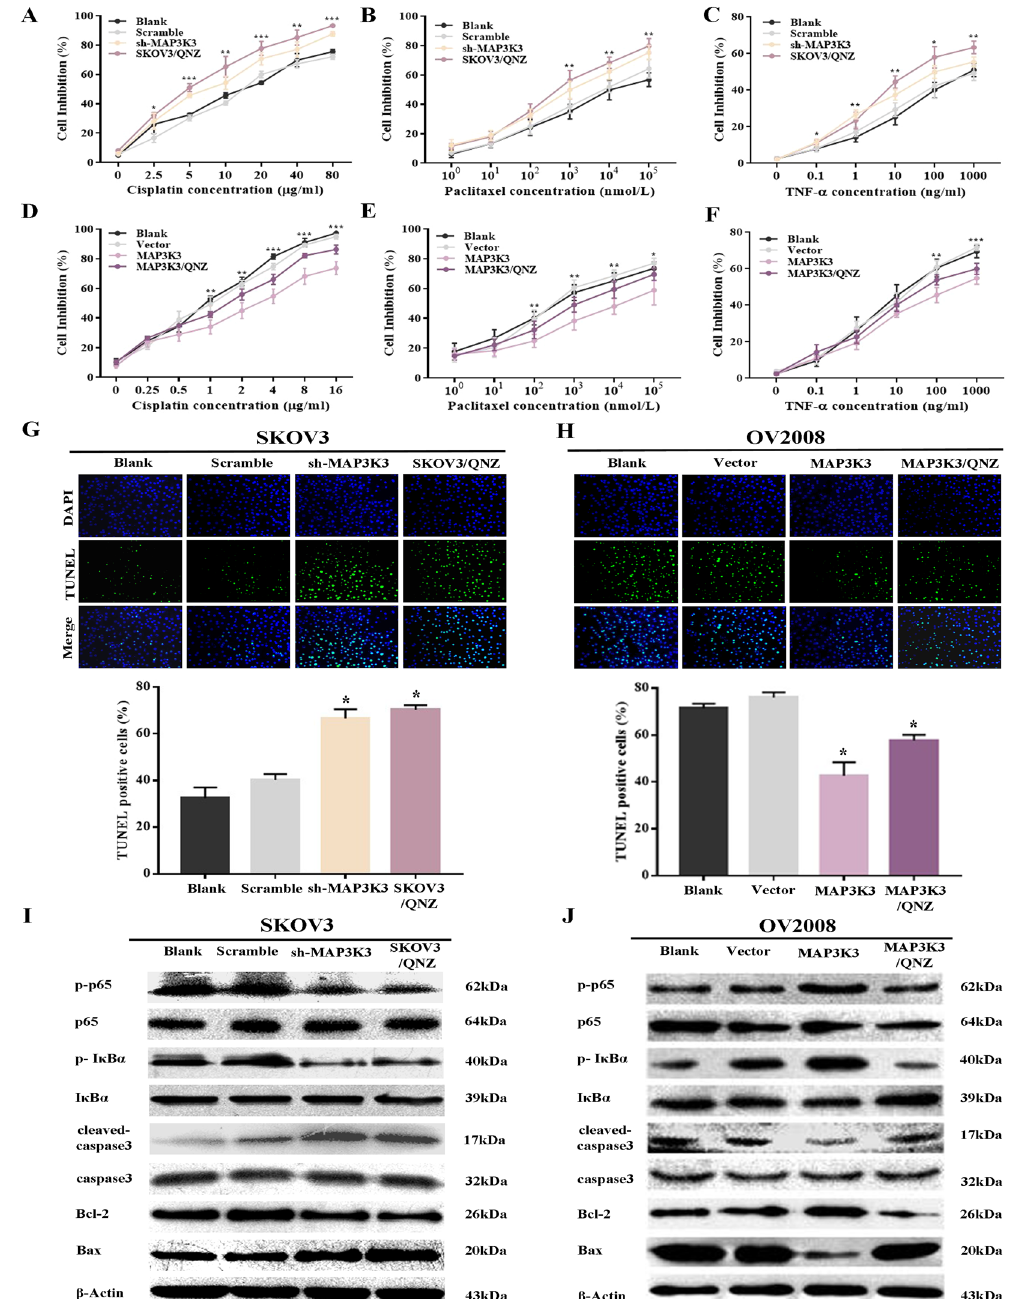
Figure 6. Relationship between MAP3K3 and chemotherapeutic sensitivity. ( A – C ) MTT assay to detect the effect of knocking down MAP3K3 expression in SKOV3 cells or blocking the NF- κ B pathway (SKOV3/QNZ) on the sensitivity to cisplatin ( A ), paclitaxel ( B ), and TNF- α ( C ). ( D – F ) MTT assay to detect the effect of overexpression of MAP3K3 and/or blocking of NF- κ B pathway (MAP3K3/QNZ) on the sensitivity to cisplatin ( D ), paclitaxel ( E ), and TNF- α ( F ). ( G , H ) TUNEL assay to detect the cell apoptosis of four groups of cells induced by cisplatin in SKOV3 ( G ) and OV2008 ( H ) cells. Blue: nucleus; green: apoptotic cells. ( I , J ) Western blot to detect the effect of MAP3K3 on the NF- κ B pathway and apoptosis-related proteins in SKOV3 ( I , Blank, Scramble, sh-MAP3K3, Blank/QNZ) and OV2008 ( J , Blank, Vector, MAP3K3 and MAP3K3/QNZ) cells. Repeated three independent experiments, * means p < 0.05, ** means p < 0.01, *** means p <